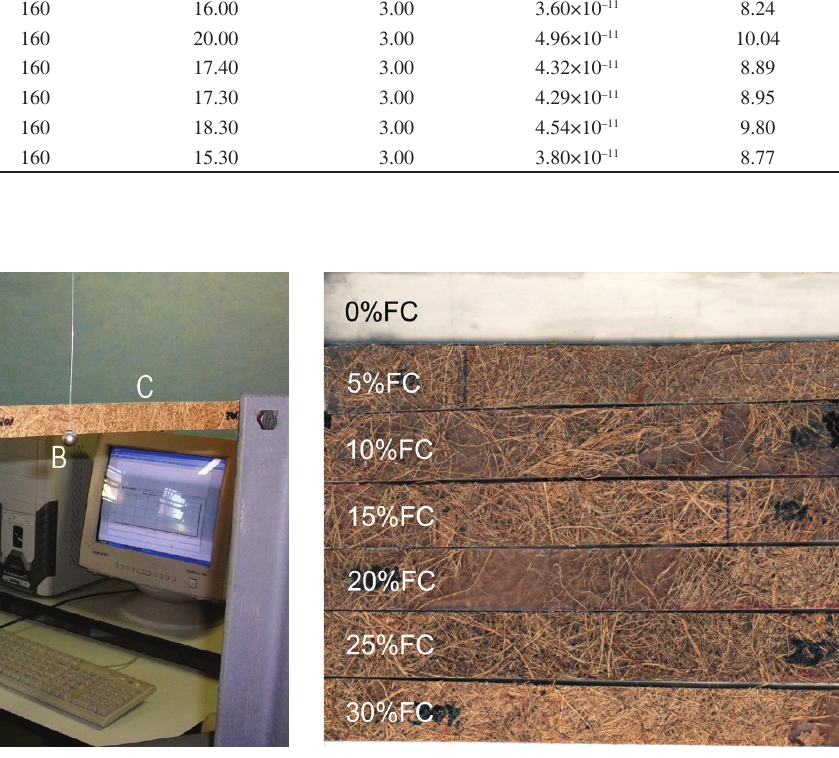
Table 3. Experimental values obtained from dynamic tests.